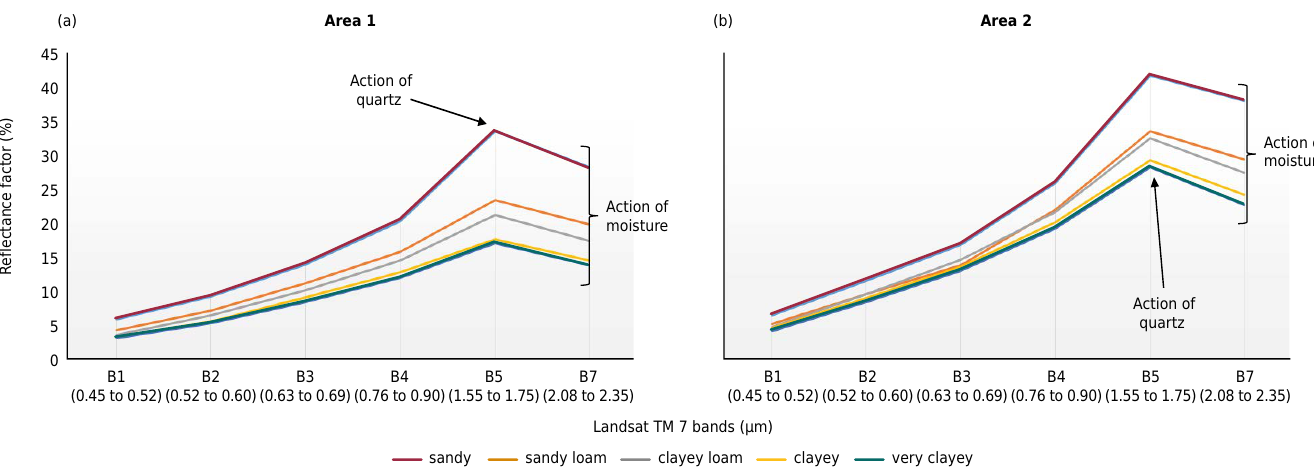
Figure 4. Spectral mean values of the textural classes obtained from the Landsat ETM +